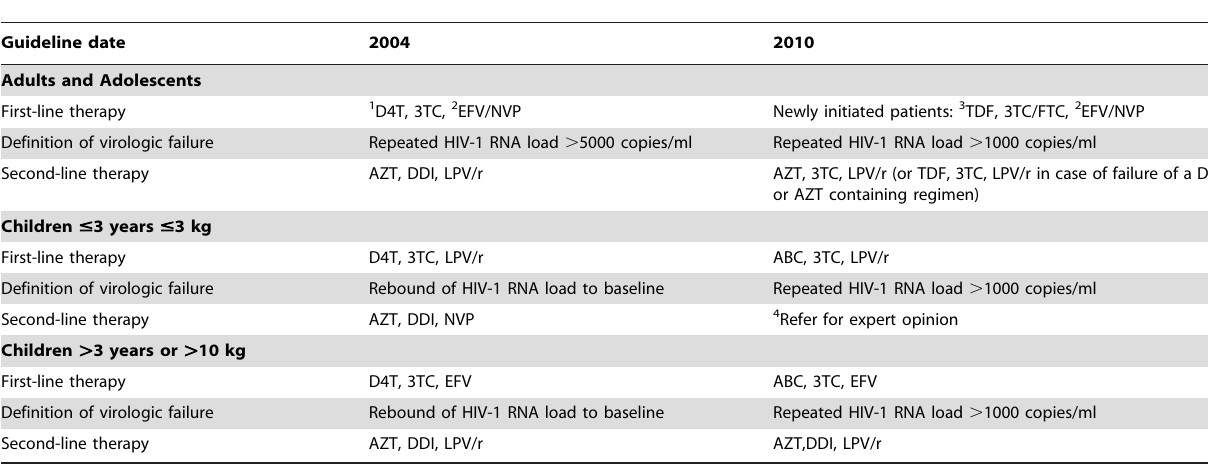
Table 1. South African National Antiretroviral Therapy Guidelines 2004 and